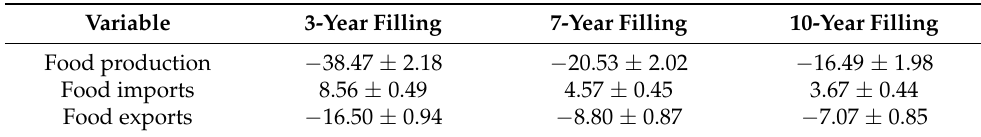
Table 5. Average annual losses/gains (%) in food production, food imports, and food exports relative to the benchmark (no GERD)